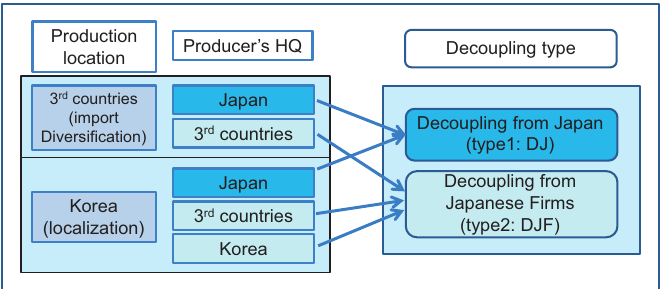
Figure 6. Korea ’ s decoupling